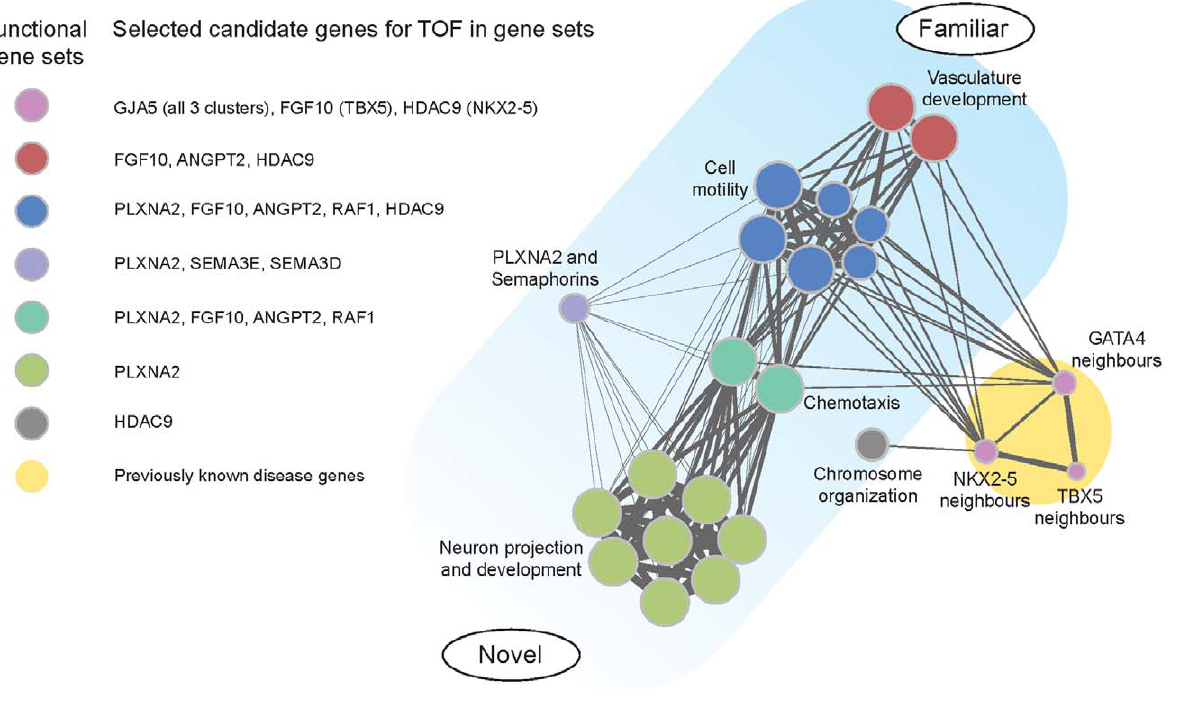
Figure 2. Functional clusters of candidate genes for tetralogy of Fallot. Diagram of results of pathway analyses comparing rare CNVs in cases and controls. Five overlapping functional clusters involved 19 gene-sets; functional neighbors of three known candidate genes identified another cluster (circle size indicates relative number of cases involved).